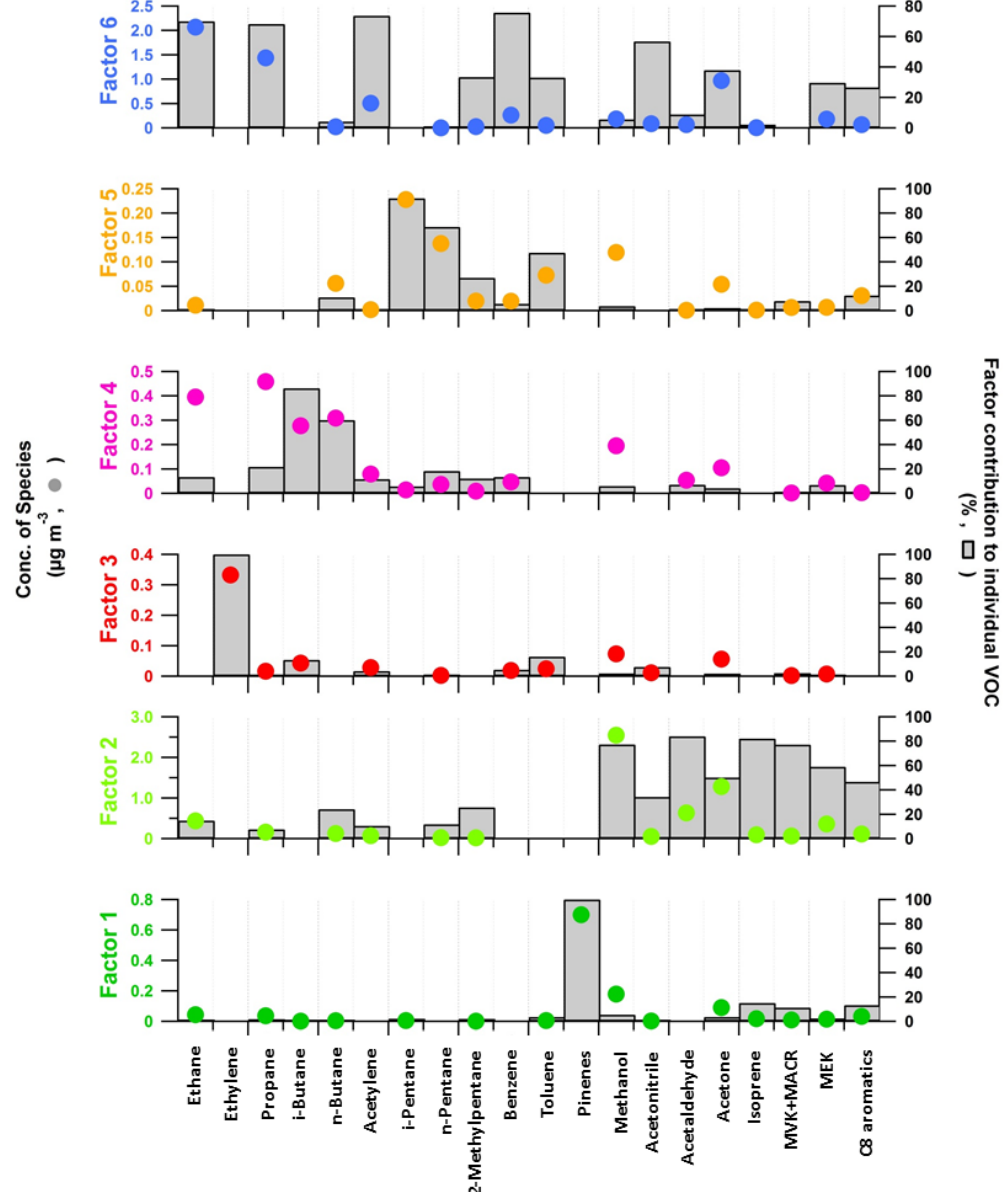
Figure 7. Chemical profiles of the six-factor PMF solution (20 VOCs). The contribution of the factor to each species (µgm − 3 ) and the percent of each species apportioned to the factor are displayed as a grey bar and a colored circle, respectively. Factor 1 – biogenic source 1; factor 2 – biogenic source 2; factor 3 – short-lived combustion source; factor 4 – evaporative sources; factor 5 – industrial and evaporative sources; factor 6 – regional